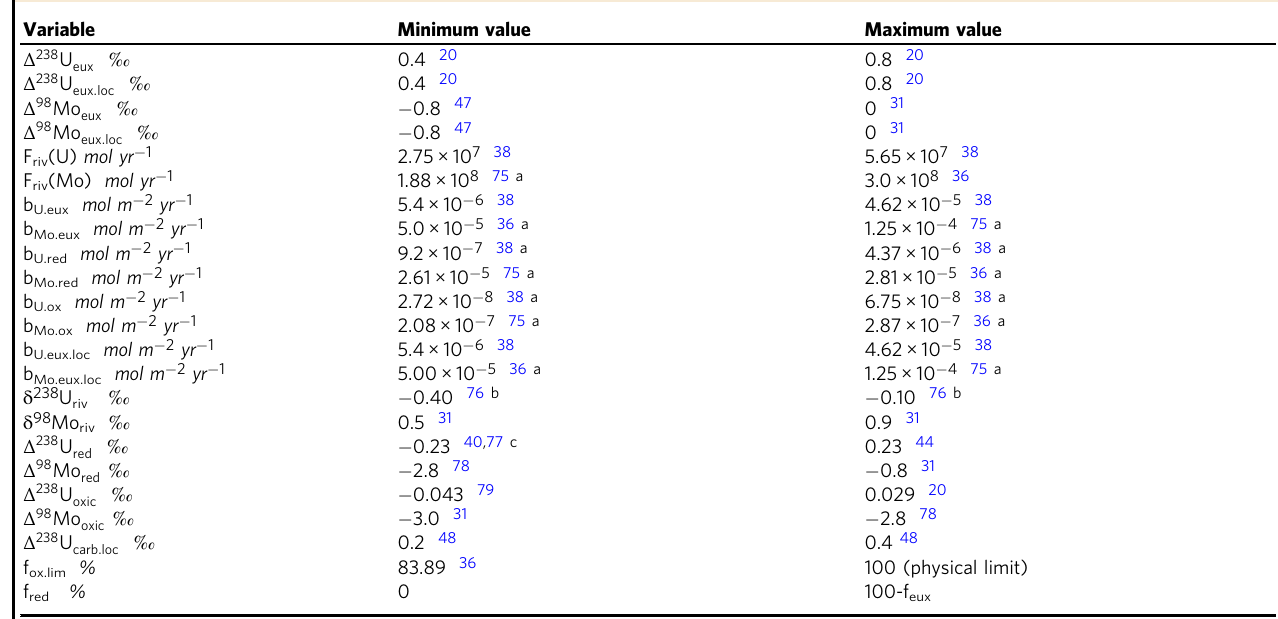
a Calculated by unit conversion. b Calculated as 5th and 95th percentile of ocean-draining rivers. c References indicate that negative fractionations are possible under reducing conditions. As quantitative constraint on the magnitude of these fractionations is poor, the magnitude of the negative fractionation is parameterized to match the positive fractionation. See Supplementary Fig. 6 for alternative